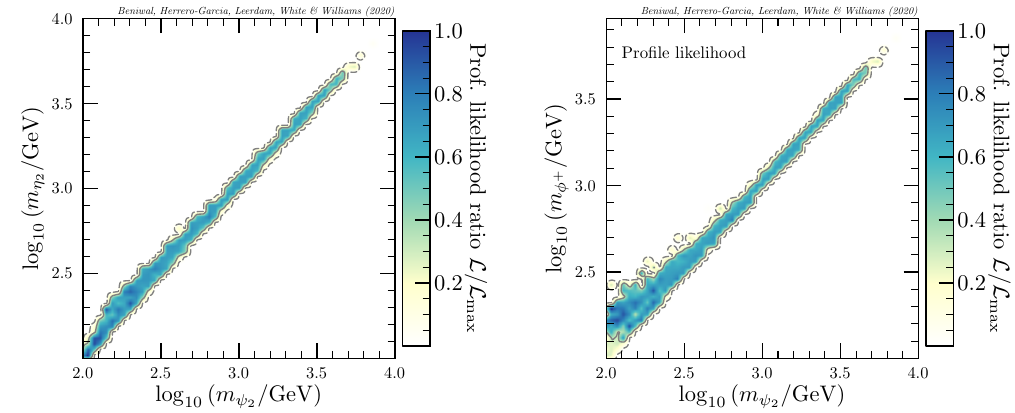
Figure 9 . 2D plots of PLR in the case of ψ 2 DM. Both panels show the need for a mass degeneracy to saturate the observed DM abundance via